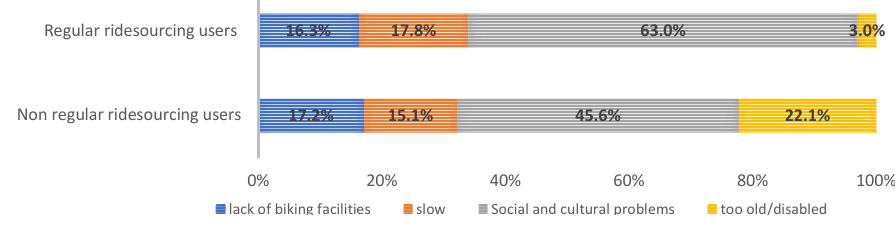
Figure 2. Reasons for not cycling among regular and non-regular ridesourcing users in the Cairo sample.